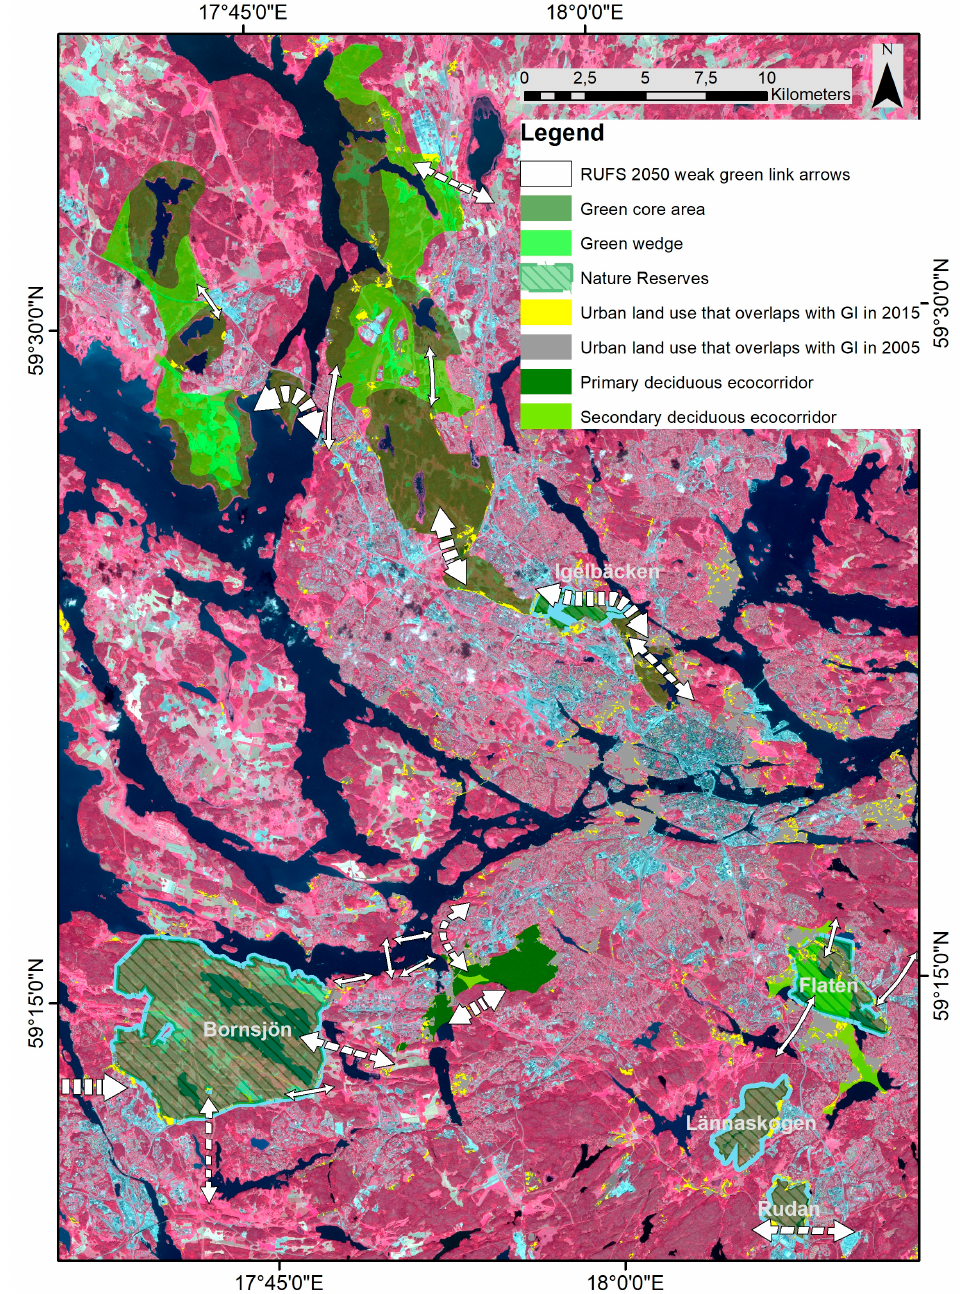
Figure 14. Overview of examples of urban impact around green infrastructure in Stockholm between 2005 and 2015. Green structure weak links according to RUFS 2050 are displayed as white arrows (larger arrows have higher restorative priority).